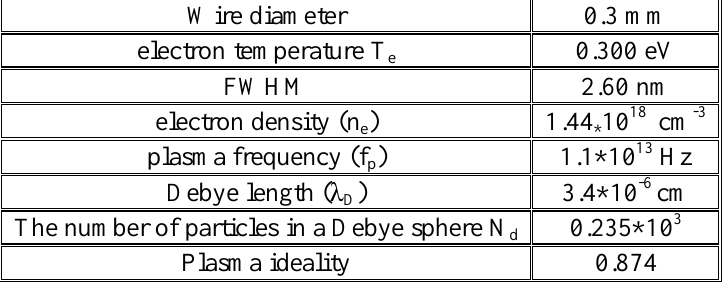
Fig. 9: Boltzmann plot from the Fe I lines produced by exploding wire. Table 2: Plasma parameters calculated from emission spectrum lines emitted from FeCoSb alloy plasma produced by exploding